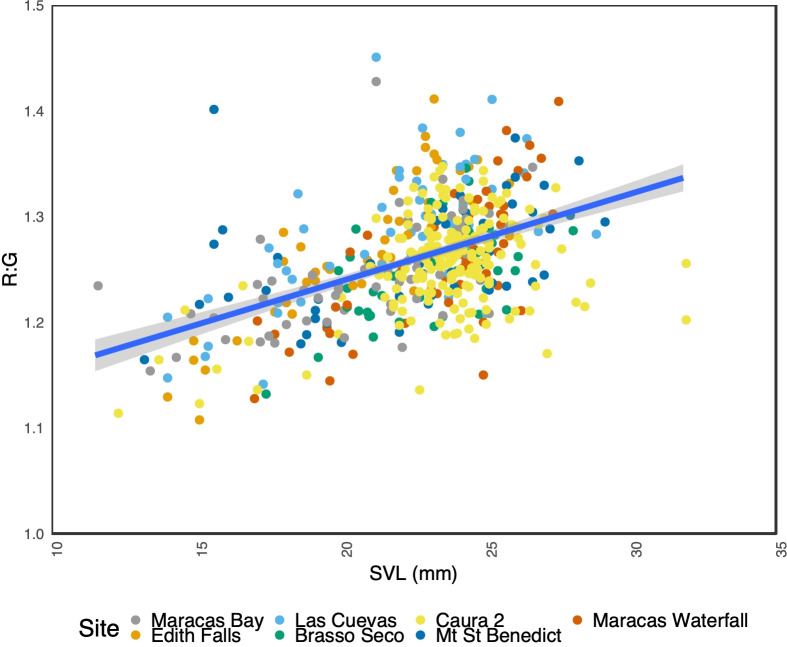
The relationship between throat patch R:G ratio and SVL (mm) in M. trinitatis for all sites.Line indicates linear regression of all sites combined. The shaded area indicates the 95% confidence interval.